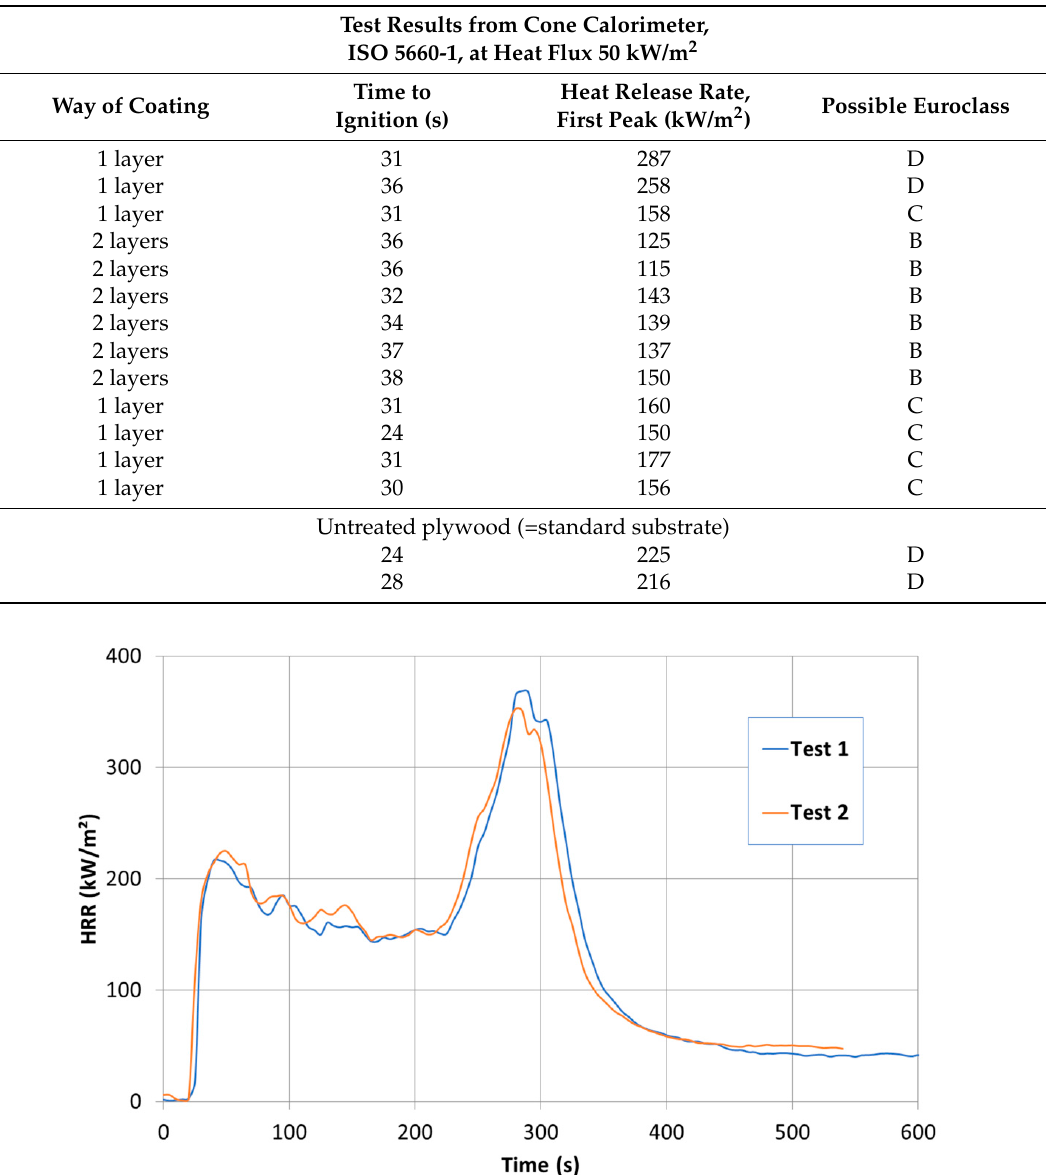
Figure 6. Heat Release Rate (HRR) curves vs. time in the cone calorimeter ISO 5660-1 for coatings WF-10, WF-11 and WF-12.